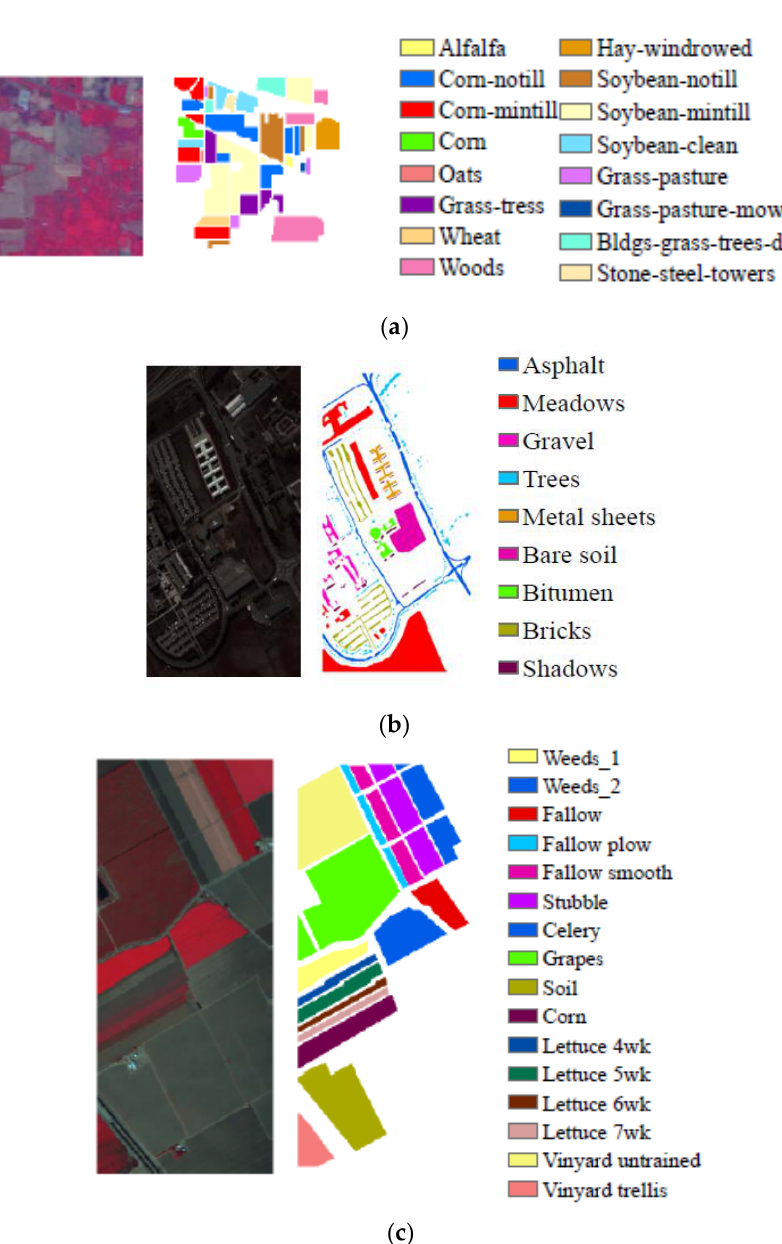
Figure 2. False color composite images with spectral bands 50, 27 and 17 (left) and ground truth (middle) with legends (right) for the three test datasets: ( a ) Indian Pines; ( b ) University of Pavia; and ( c ) Salinas.